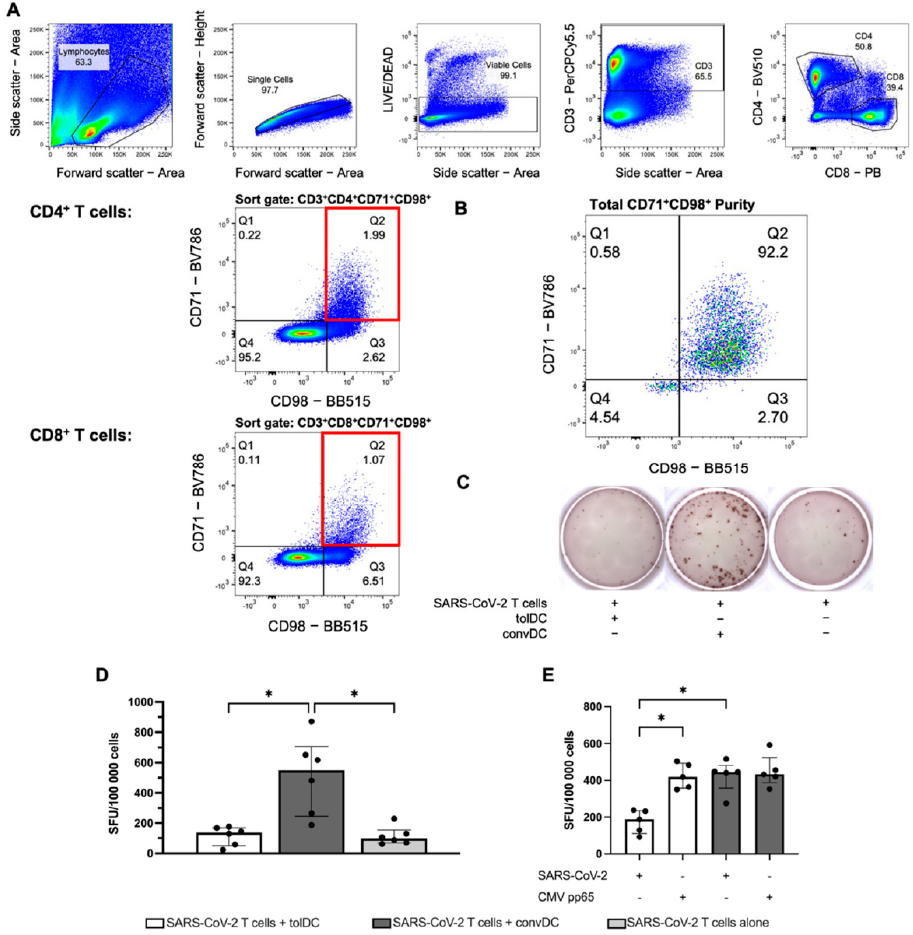
Figure 2. TolDC induce SARS-CoV-2-specific T cell hyporesponsiveness. ( A ) Gating strategy for the sorting of CD3 + CD4 + CD71 + CD98 + and CD3 + CD8 + CD71 + CD98 + cells. Cells were sorted from left to right as lymphocytes (FSC-A, SSC-A), single cells (FCS-A, FSC-H), viable cells (Fixable Near-IR Dead Cell Stain) and subsequent surface marker selection, with the sort gates indicated in red, ( B ) Representative figure of an FACS-sorted CD3 + CD71 + CD98 + T cell population indicating the purity of the sort. ( C ) Representative figure of the IFN- γ ELISpot wells from SARS-CoV-2-specific T cells stimulated with tolDC or with convDC, or SARS-CoV-2-specific T cells alone and rechallenged with SARS-CoV-2 peptides. ( D ) SFU counts normalized to SFU/100.000 cells in cocultures of SARS-CoV- 2-specific T cells stimulated with tolDC (white bars) or with convDC (black bars) or SARS-CoV-2- specific T cells alone (grey bars). A p -value < 0.05 is indicated by * (n = 6). ( E ) Antigen-specific T cell stimulatory capacity in PBL stimulated with tolDC (white) or convDC (black) in the presence SARS- CoV-2 peptides and restimulated in an ELISpot assay with either SARS-CoV-2 peptides or CMV peptides. A p -value < 0.05 is indicated by * (n = 5). Abbreviations used: spot forming units (SFU), tolerogenic dendritic cells (tolDC), conventional dendritic cells (convDC), Interferon-gamma (IFN- γ ). Additionally, to investigate whether the induction of SARS-CoV-2-specific T cell hyporesponsiveness by vitD 3 -treated tolDC was antigen-specific, PBL stimulated with vitD 3 -treated tolDC in the presence of SARS-CoV-2 peptides were rechallenged with SARS-CoV-2 peptides or with an irrelevant peptide pool, namely, cytomegalovirus (CMV) pp65 (Figure 2E). Similarly, as with SARS-CoV-2-specific T cells, the stimulation of PBL with vitD 3 -treated tolDC in the presence of SARS-CoV-2 peptides results in a sig- nificantly lower number of SFU (187.3 SFU, IQR: 110.2–234.7), as compared to the stimu- lation of PBL with convDC (445.7 SFU, IQR: 357.8–482.5; p = 0.0163), when cells were